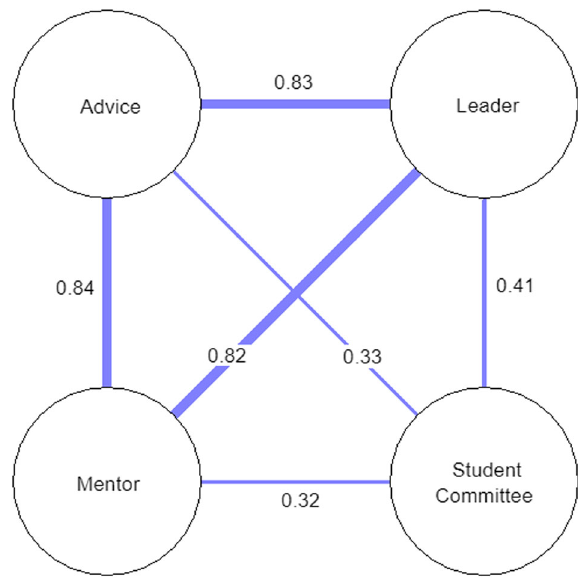
Fig. 3 Each node (circle) represents one of the social networks, and the thickness of the edge between two circles is proportional to the average Pearson correlation between the given networks across all teams. We see the advice, leader, and mentor networks were highly correlated but only weakly correlated with the student committee